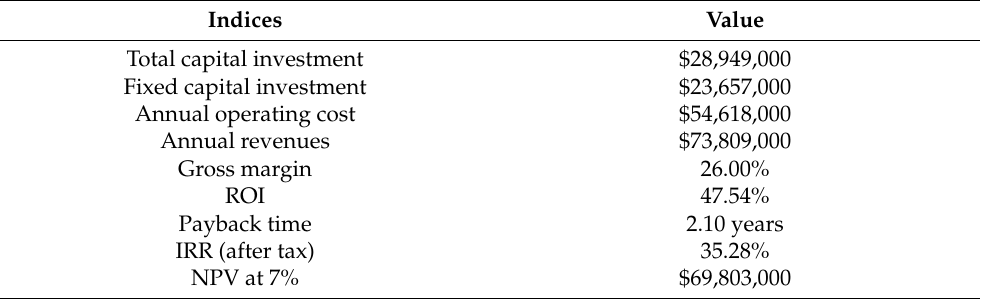
Table 7. Key project totals and indices associated with the specific MixAlco design.